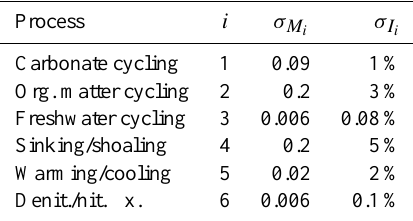
) and I i variability ( σ I ) for atmospherically isolated mean seawater from i i